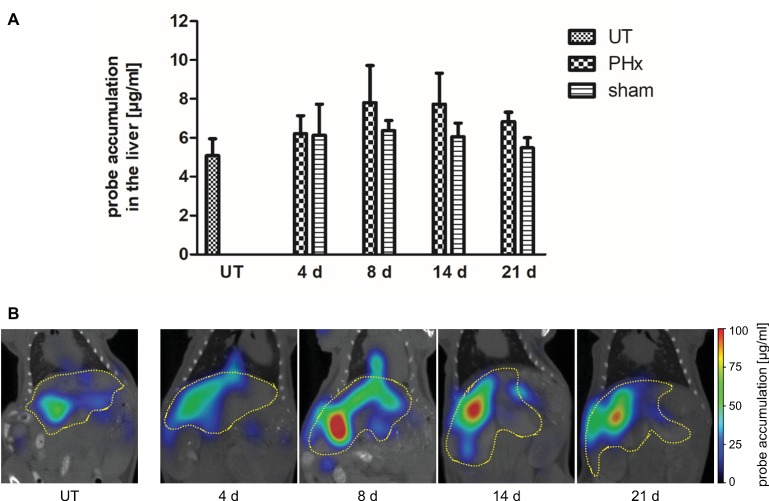
In vivo assessment of CD68+ macrophages in untreated control mice, sham-operated mice and mice after PHx. CD68+ macrophages were non-invasively monitored by FMT-μCT at day 4, 8, 14, and 21 after PHx and sham surgery and in untreated control mice. (A) Quantitative analysis showed a higher mean NIRF CD68 probe concentration in the liver at day 8, 14, and 21 after PHx compared to untreated and sham-operated control mice. The highest mean concentration was reached at day 8 (data are presented as mean values ± SD). (B) Representative frontal plane FMT-μCT fusion images of an untreated control mouse and mice after PHx show a higher fluorescent signal in the liver of mice at day 8, 14 and 21 after PHx (dashed yellow line indicates the liver). UT, untreated mice.